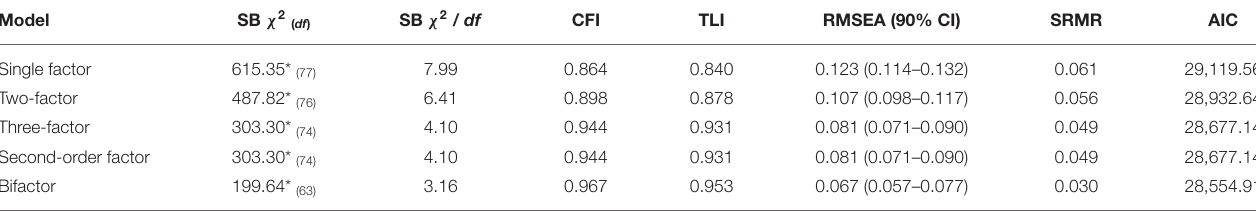
TABLE 2 | Confirmatory factor analysis fit statistics.